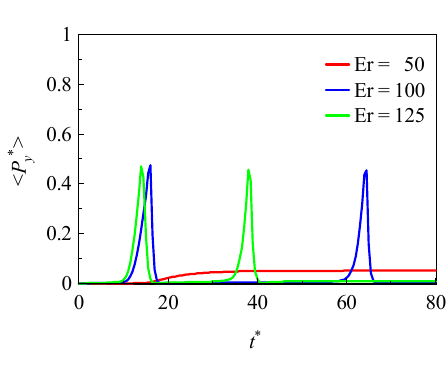
Fig.15 Flexoelectric polarization as a function of time for